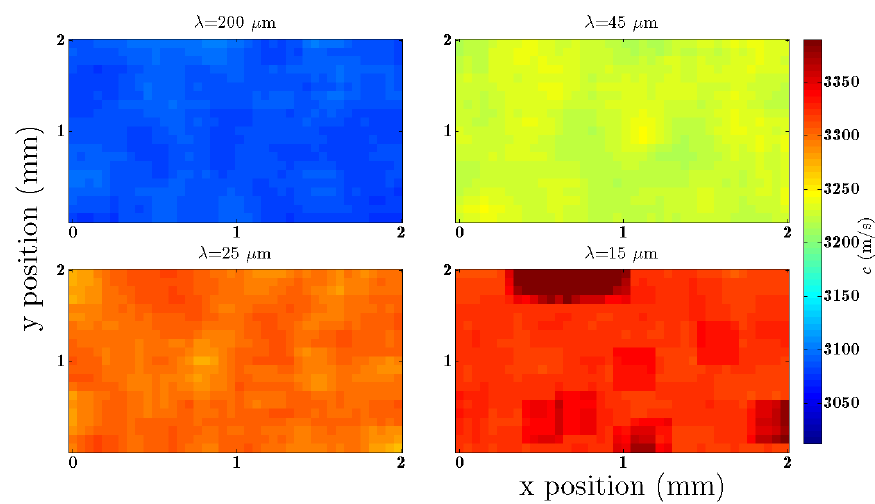
Figure 10. Topographic image of the position dependent phase velocities for a set of four different gratings. These images are the result of an interpolation executed on the rough, wavelength dependent, phase velocities c R ( x k , y k ) along a grid of 21 × 40 points in the xy -plane. The same color scale is used for all the four images to compare the phase velocities mutually.